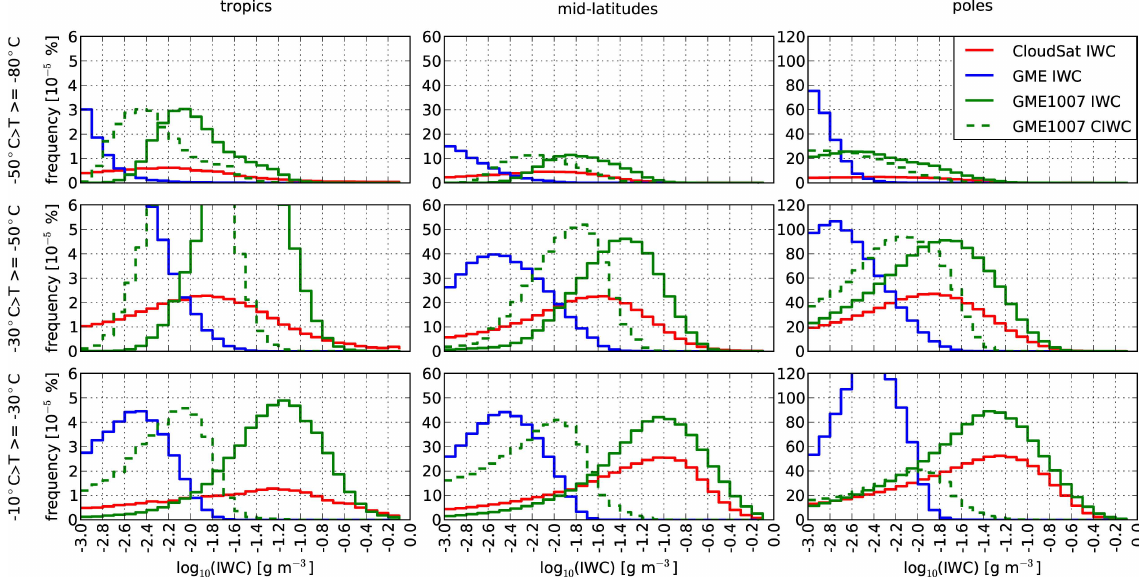
Fig. 6. Histograms of frequency distributions of IWC for 1 July 2009 to 31 October 2009 for three temperature ( − 10 to − 30 ◦ C (bottom), − 30 to − 50 ◦ C (middle), − 50 to − 80 ◦ C (top)) and three latitudinal (tropics (left), mid-latitudes (middle), polar regions (right)) regimes. Red: CloudSat; blue: GME; green: GME1007. Solid: IWP; dashed: CIWP. Normalized with total number of pixels.